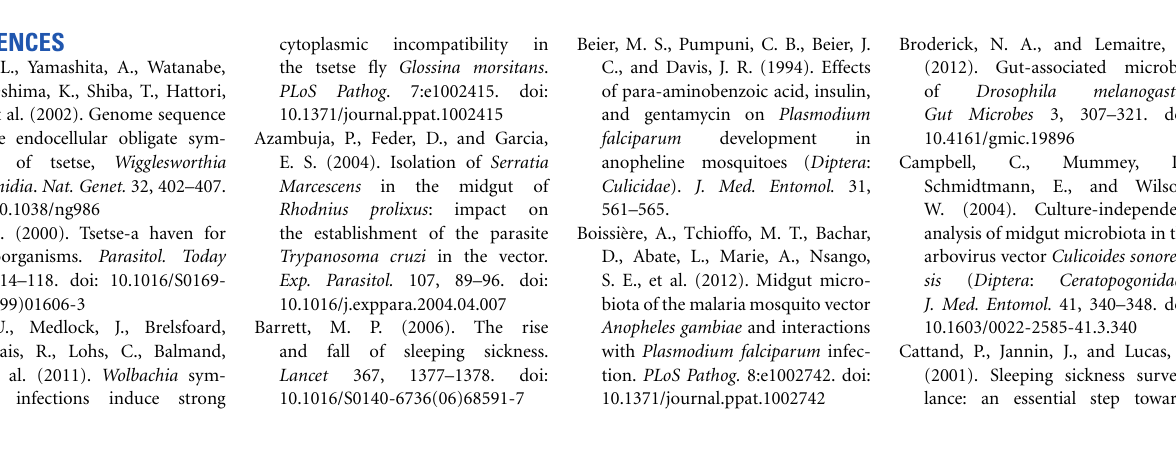
on several insect systems indicate that both direct and